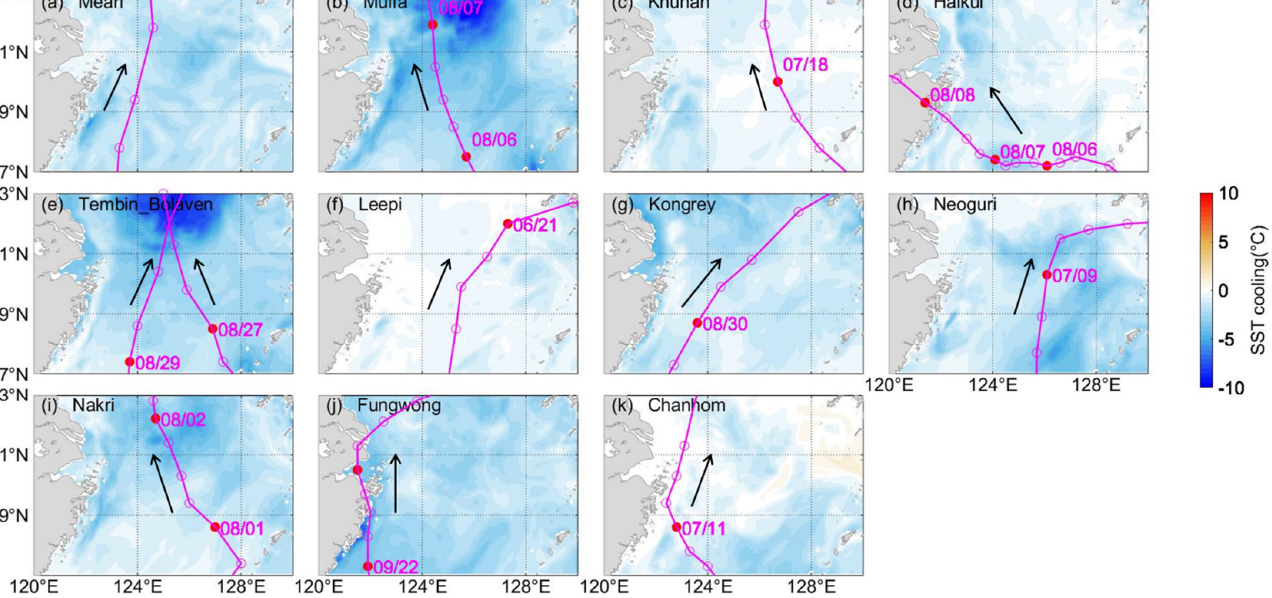
Figure 7. SST cooling of Zhejiang coastal waters caused by the 12 typhoons: ( a ) Meari, ( b ) Muifa, ( c ) Khunan, ( d ) Haikui, ( e ) Tembin_Bolave, ( f ) Leepi, ( g ) Kongrey,( h ) Neoguri, ( i ) Nakri, ( j ) Fungwong and ( k ) Chanhom. The black arrow(s) in each subfigure denotes the moving direction of the ty- phoon(s).